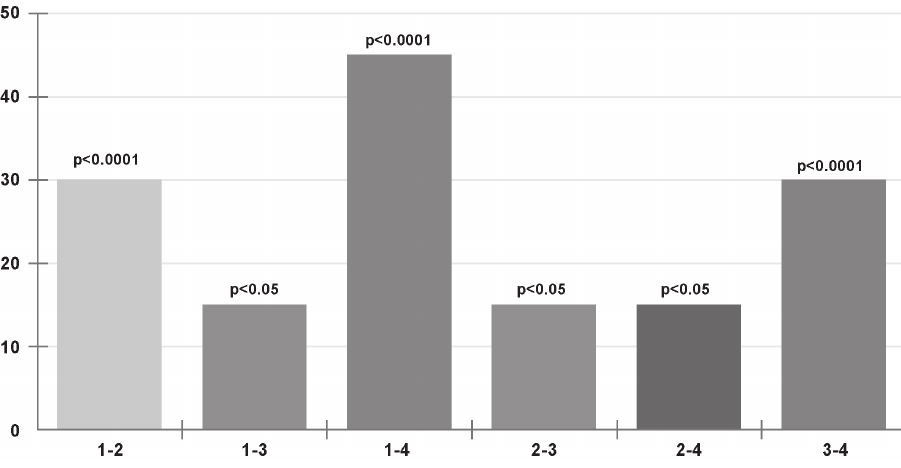
Figure 3- Intergroup comparisons (Kruskal-Wallis;